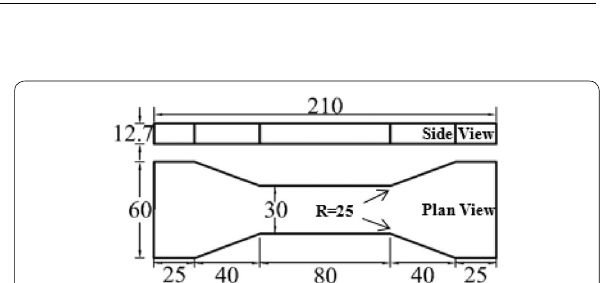
Fig. 1 Tensile test